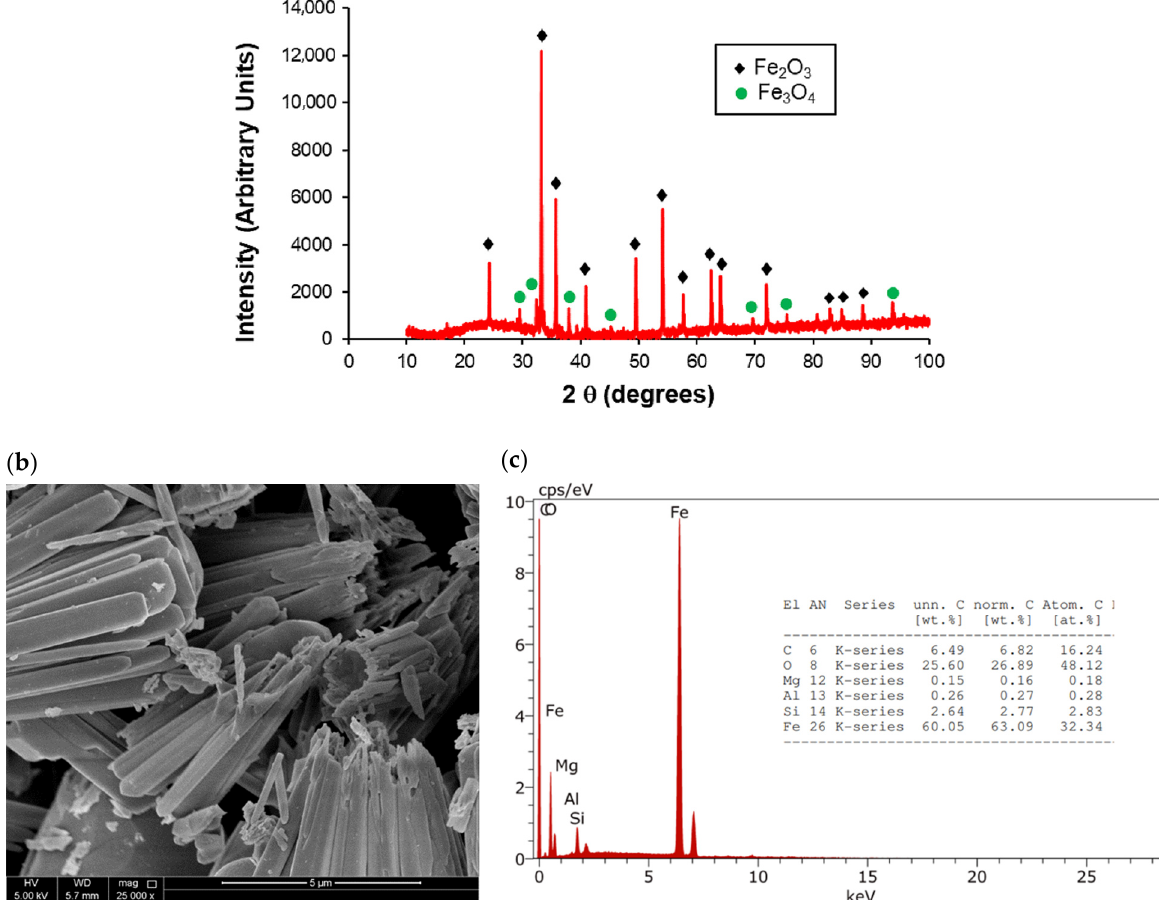
Figure 1. ( a ) XRD spectrum, ( b ) SEM image, and ( c ) EDS spectrum of the natural Fe-based catalyst.